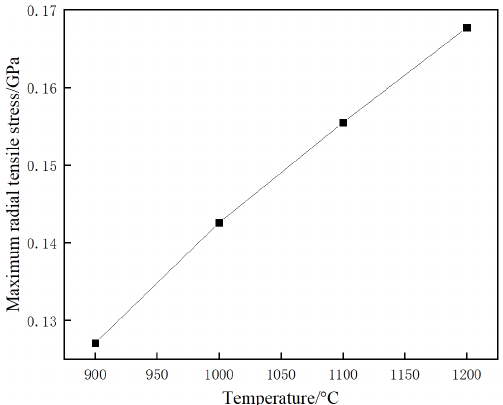
Figure 8. Relationship between the maximum negative shear thermal stress on the surface of the LMA layer of the M2S1 specimen and the working temperature .